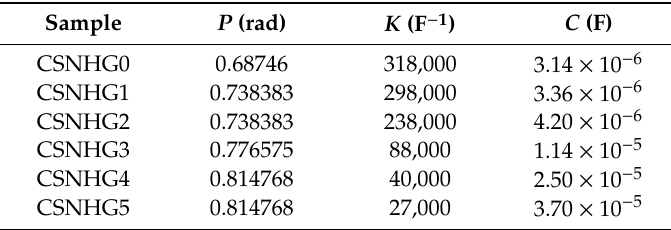
Table 1. The EEC fitting parameters for all electrolyte systems at ambient